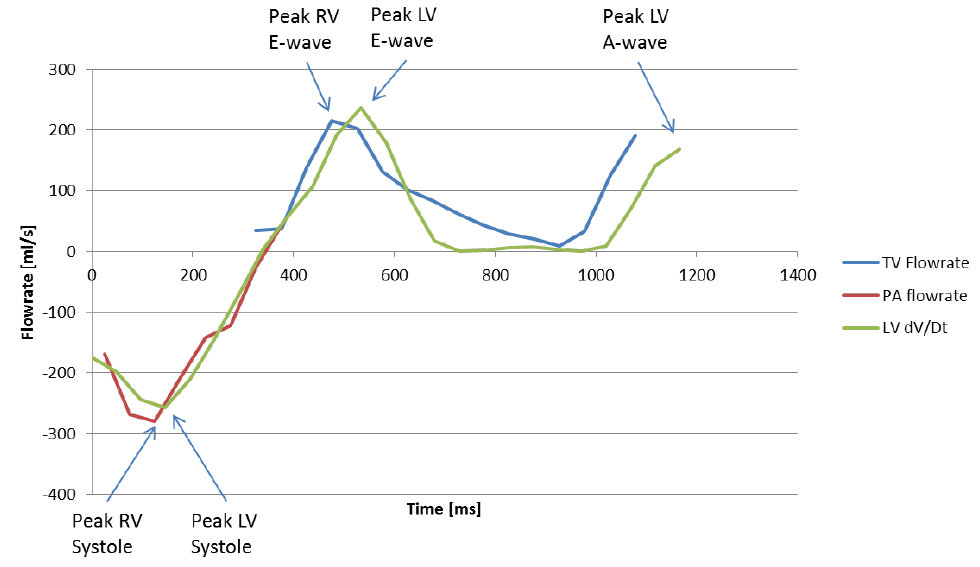
Figure 7. TV and MPA flowrates and time derivative of LV volume for a normal subject.